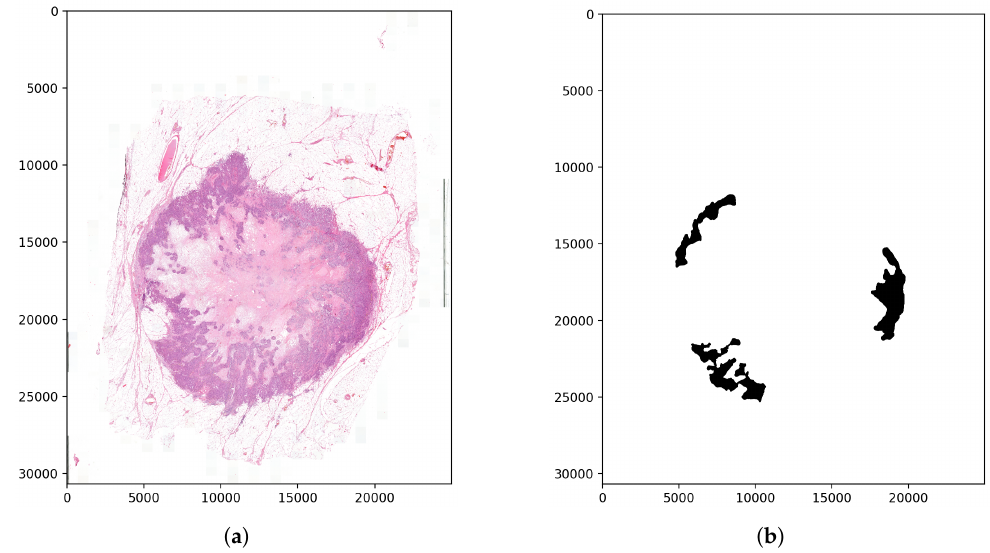
Figure 11. Examined tissue image and the tumor annotations. ( a ) Image of the examined tissue sample. ( b ) Annotation mask of the tumor